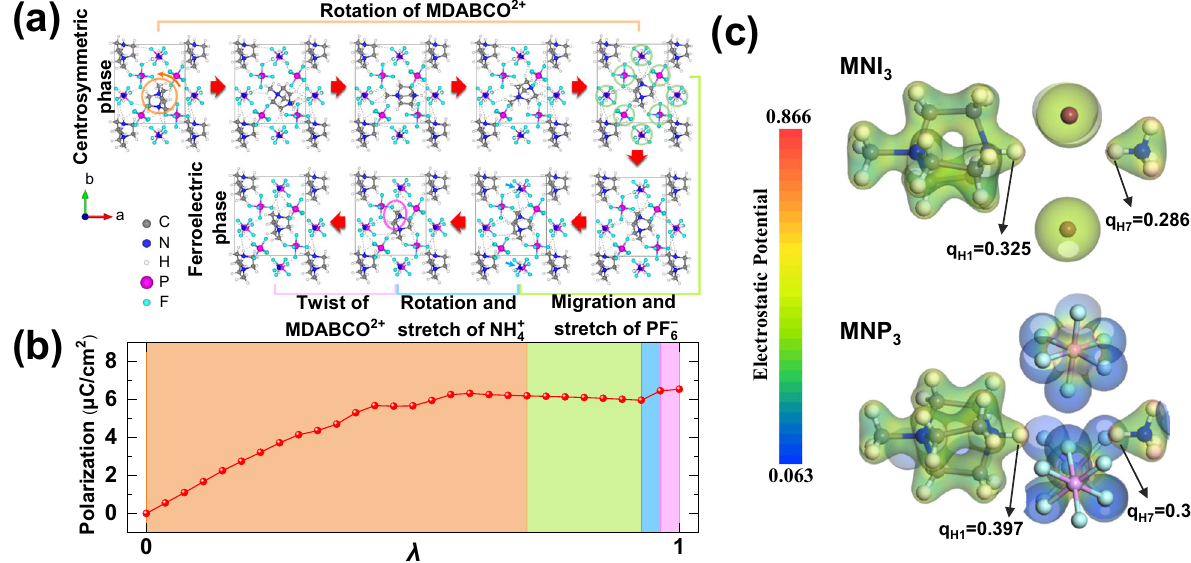
Fig. 5 Berry phase calculation of spontaneous polarization in MNP 3 . a The dynamic path of ferroelectric phase transition in MNP 3 . b The polarization value of MNP 3 was obtained by Berry phase calculations. The path connects the centrosymmetric reference phase ( λ = 0) to the ferroelectric phase ( λ = 1). c Electrostatic potential of MNI 3 and MNP 3 , and the Mulliken charges of H atoms participating in hydrogen